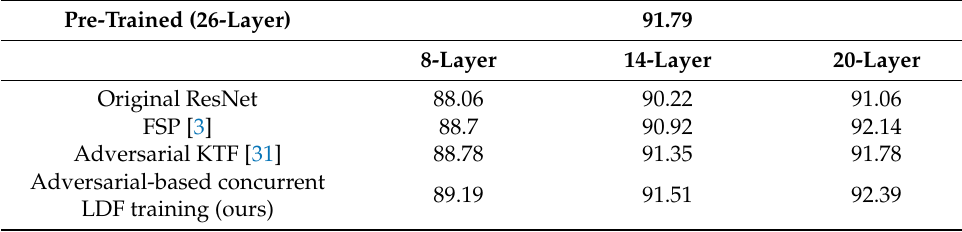
Table 6. Averaged accuracy (%) of CIFAR-10.